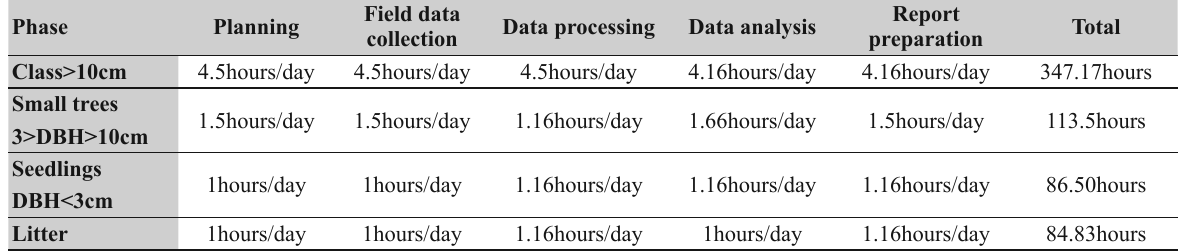
Number of hours spent per activity per